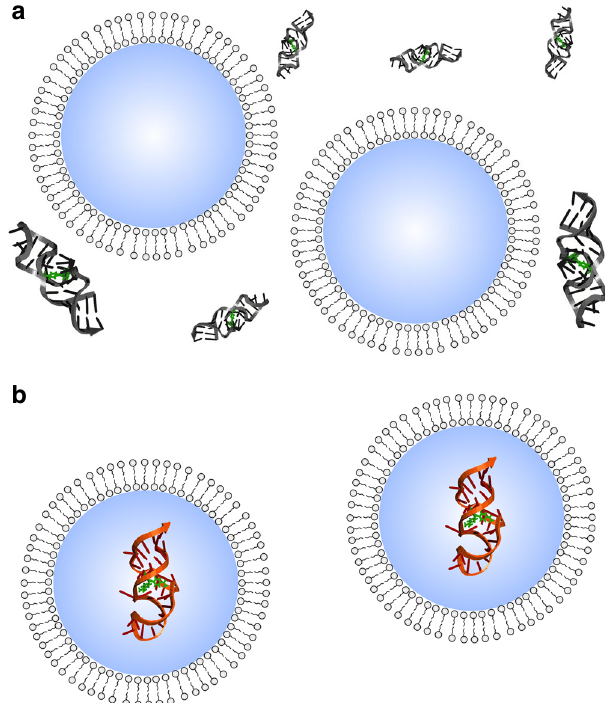
Fig. 1 Schematic representation of the MG aptamer in different conditions. a Exposed to ‘ empty ’ vesicles and b encapsulated inside